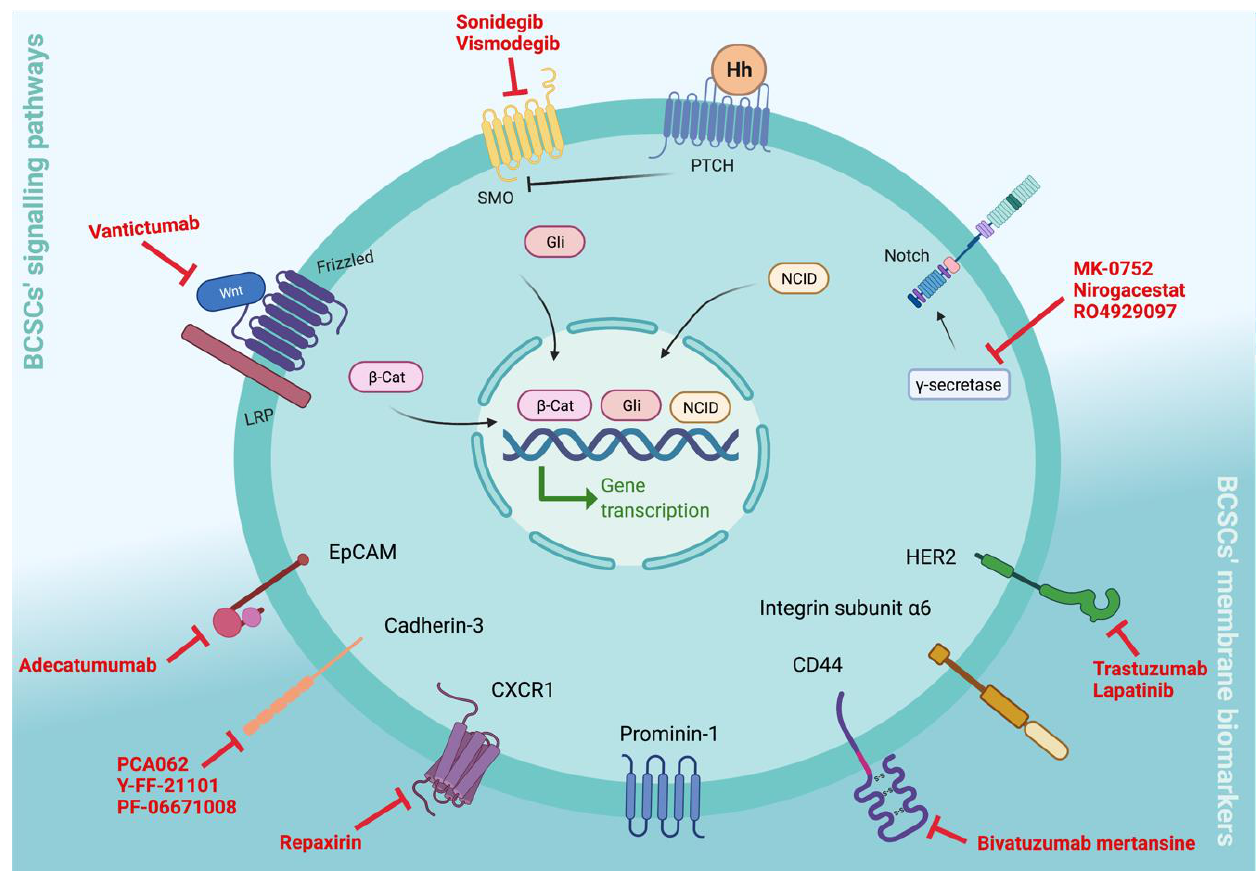
Figure 3. Breast cancer stem cell membrane biomarkers, signalling pathways, and targeting therapies in clinical trials. CD44, integrin alpha 6, EpCAM, Cadherin 3, HER2, prominin-1, and CXCR1 are commonly recognised as CSC membrane biomarkers, whose expression has been associated with breast cancer. Bivatuzumab mertansine is a CD44v6-targeted therapy that has been tested in phase I clinical trials in anthracycline and taxane pretreated patients with metastatic breast cancer who were shown to have CD44v6 expression. Adecatumumab is an EpCAM-targeting antibody already in phase II clinical trials; however, it does not have a significant impact on EpCAM overexpressing breast cancer patients. PCA062, Y-FF-21101, and PF-06671008 are molecules that specifically target cadherin-3 that are currently in clinical trials. Trastuzumab and lapatinib are drugs already in clinical practice as HER2-targeted therapies, which emerging studies describe as contributing to BCSC elimination. Repaxirin is in phase II clinical trials for CXCR1 inhibition, showing interesting results in the reduction in BCSC content. Since Wnt– β -catenin, Hh, and Notch signalling are associated with self-renewal, differentiation, apoptosis, and survival, they are usually upregulated in cancer and are, therefore, seen as promising for CSC-targeting therapies. In particular, for breast